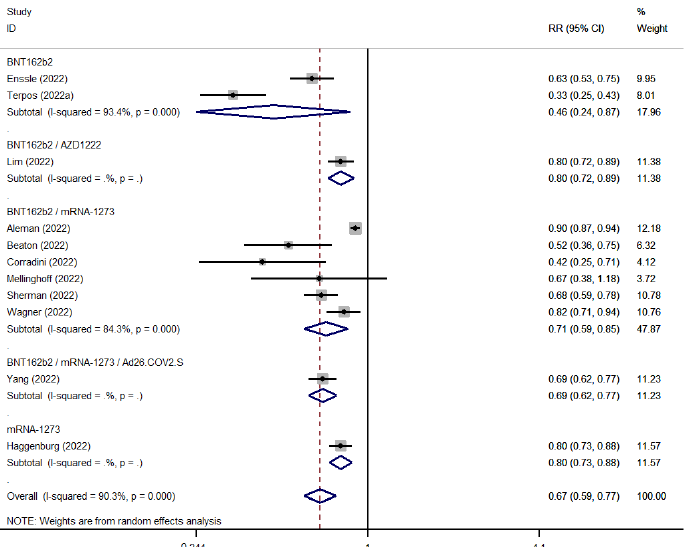
Figure 7. Pooled RelativeRisk (RR) for the immune seroconversion of patients with hematological malignancies after the third dose of COVID-19 vaccine [95,99,103,107–110,116,124,127,131].